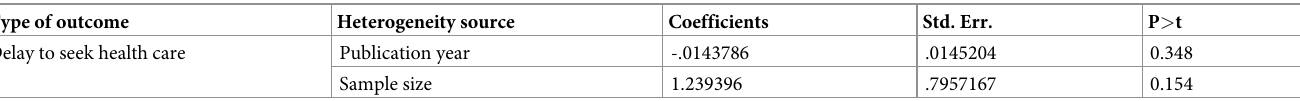
Table 2. Meta-regression analysis of factors affecting between-study